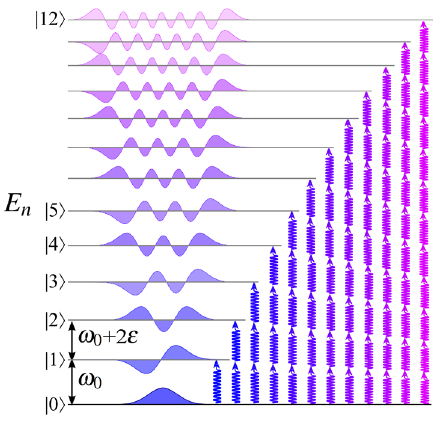
Figure 2. Sketch of multi-photon transitions in the cavity with a negative anharmonicity ε < 0 . Eigenstates 1 ) where n is the respective photon number. A n ω 0 n ε n ( n have non-equidistant spectrum E n | � = + − 0 n multi-photon transition from to is accompanied by the absorption of n photons of the frequency | � | � 1 ) . The decrease of ω n with n for ε < 0 is illustrated by a change of color from blue to ω n ω 0 ε( n = + −